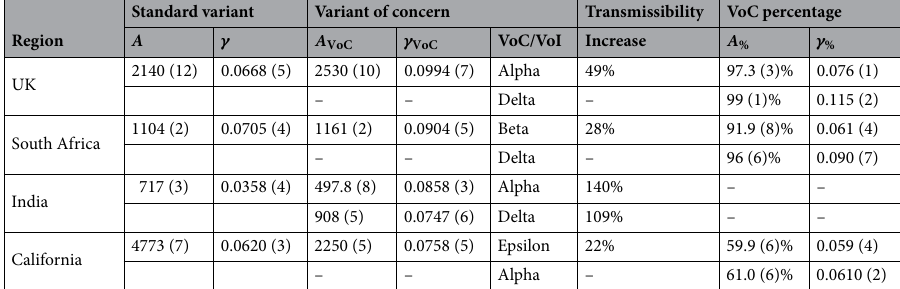
Table 2. MeRG fit parameters. Parameters from the fit of the VoC/VoI for the UK, South Africa, California and India, also shown in Fig. 6. The fit follows the MeRG model, according to which each variant can be fitted by an independent logistic function. For the UK, the “standard variant” fit corresponds to the first peak, in October–November 2020. The transmissibility increase is computed by comparing the gamma of the VoC with that of the standard variant in the same country. For the new variants that have not reached the peak of diffusion, it is not possible to extract reliable values for the eRG